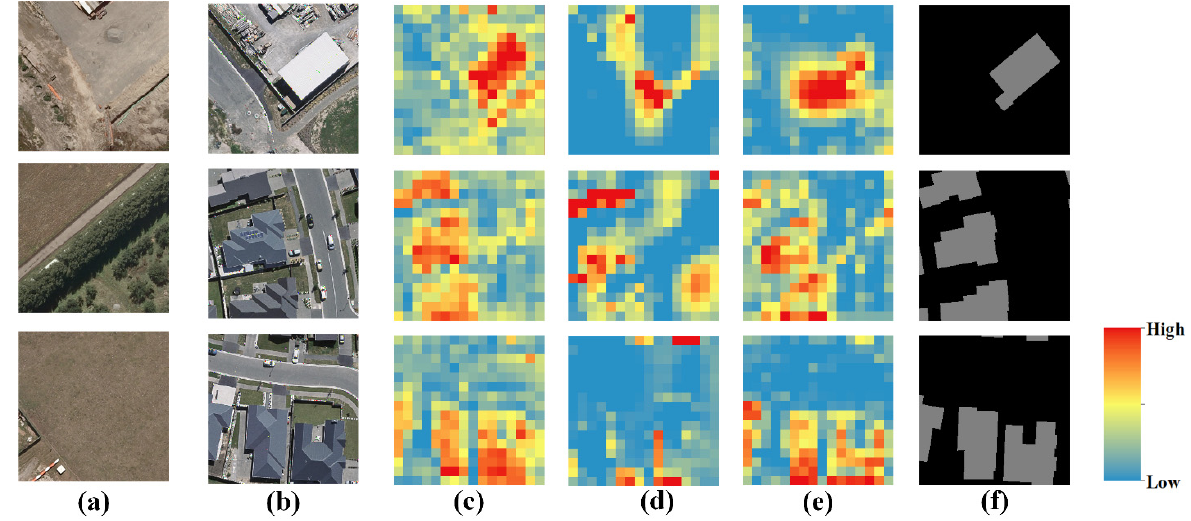
Figure 7. ( a ) Before image; ( b ) After image; ( c ) MDEFNET-LL; ( d ) MDEFNET-HL; ( e ) MDEFNET; ( f ) Label.